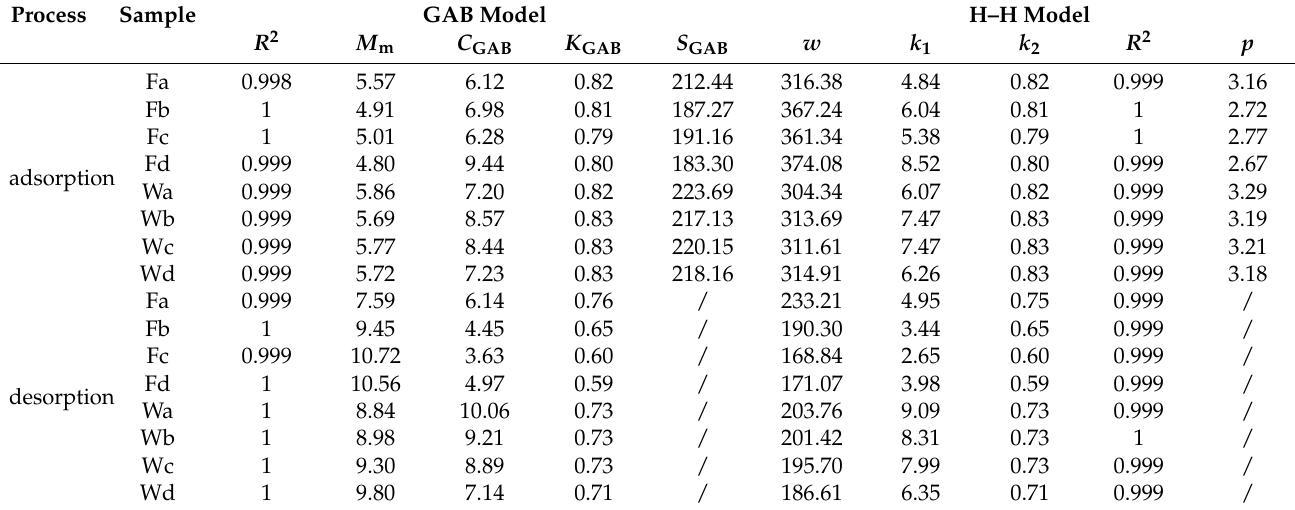
Table 1. Coefficients of the Guggenheim Anderson de Boer (GAB) and Hailwood–Horrobin (H–H) models for waterlogged archaeological wood and recent